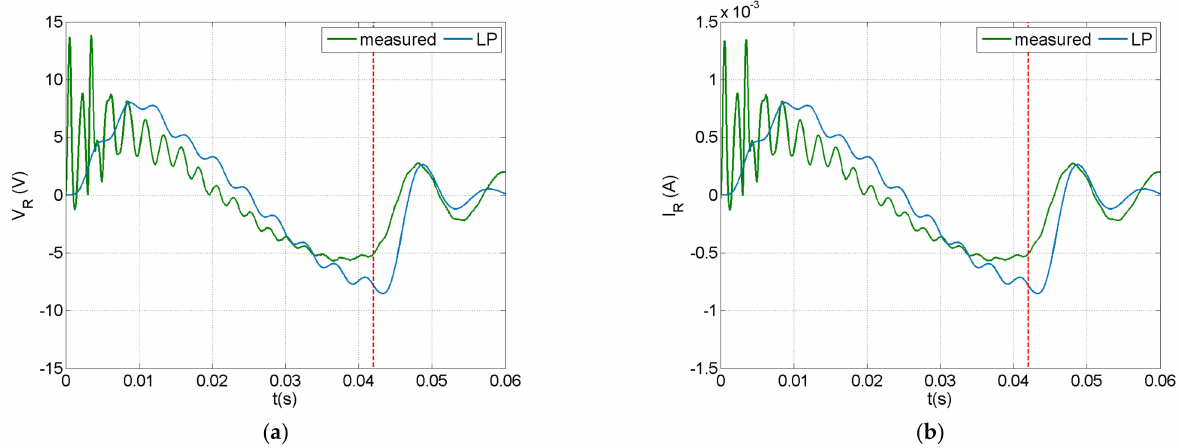
Figure 8. Impact response in a resistive circuit with R = 10 k Ω : ( a ) resistor voltage, ( b ) circuit